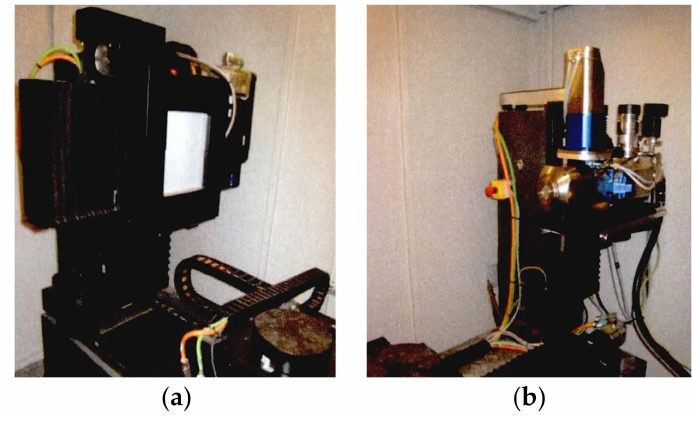
Figure 3. CT scanning system: ( a ) flat panel detector, ( b ) X-ray source.